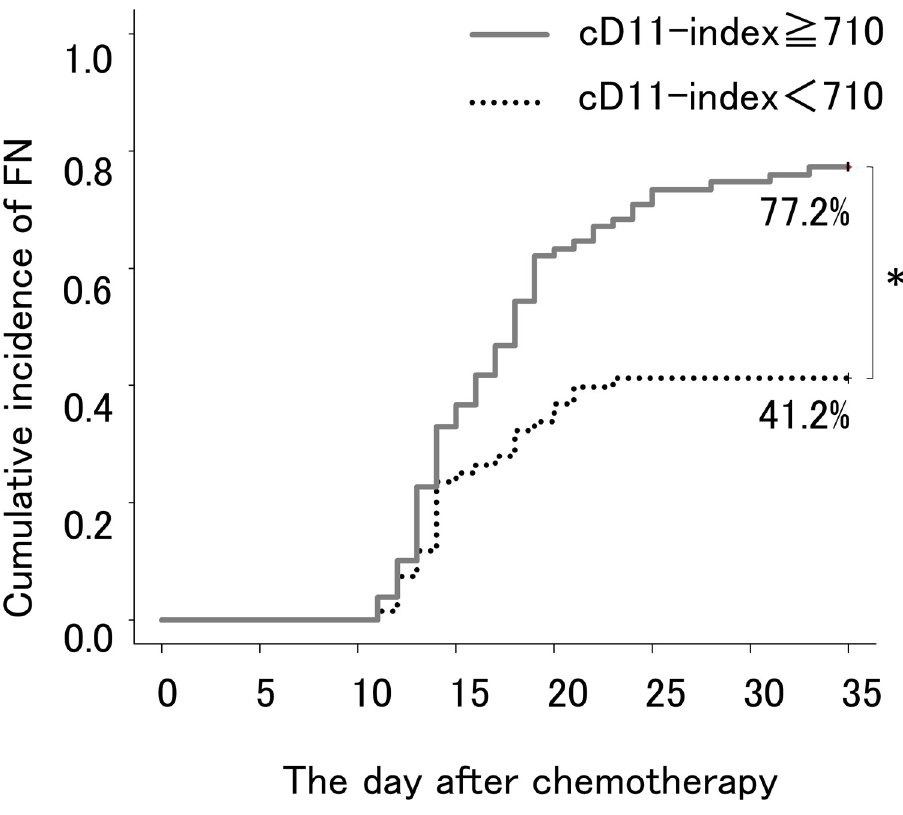
Fig 5. Cumulative incidence of febrile neutropenia (FN) according to defined c-D11-index value. The cumulative incidence of FN was significantly higher in the group with c-D11-index � 710 (77.2%) than in the group with c-